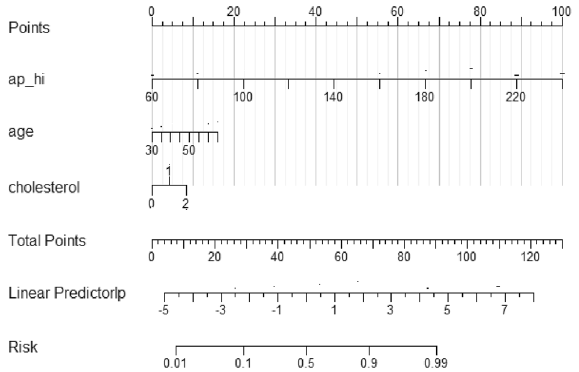
Figure 5. Representation of the XGBH static nomogram.